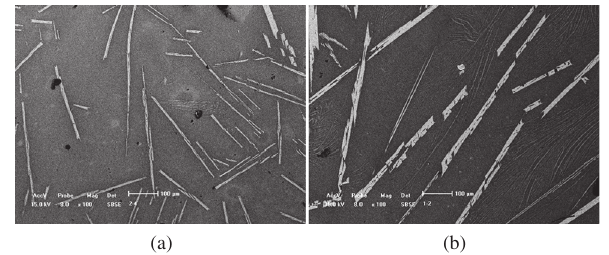
Figure 3: Backscattered electron image of the quenched sample